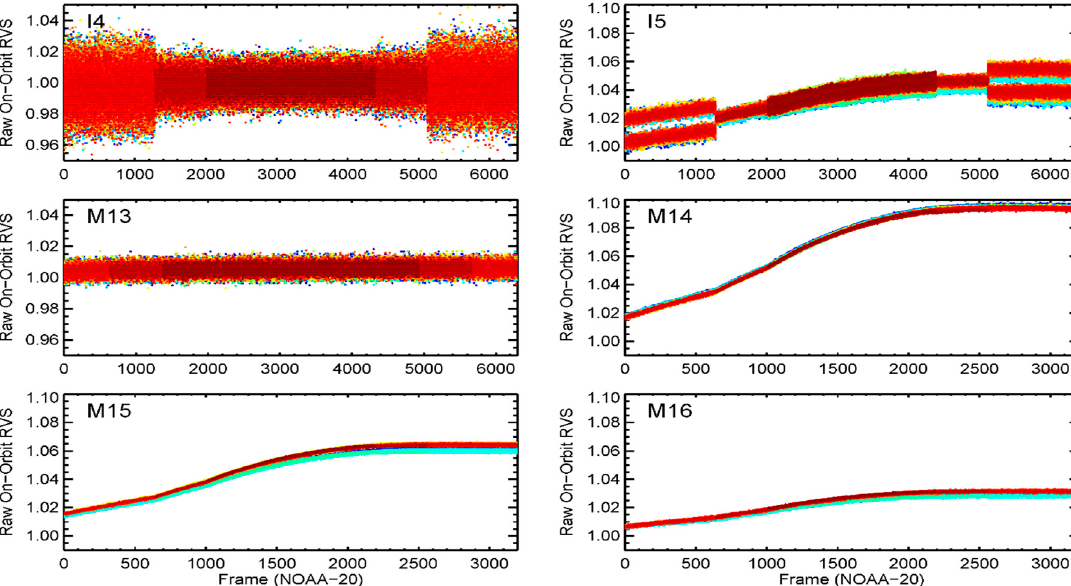
Figure 6. The Wang et al. method derived NOAA-20 raw (pixel level) on-orbit RVS data as function of frame. For each band, detector level raw RVS are illustrated by different colors ranging from blue (HAM-A, first detector) to dark red (HAM-B, last detector).